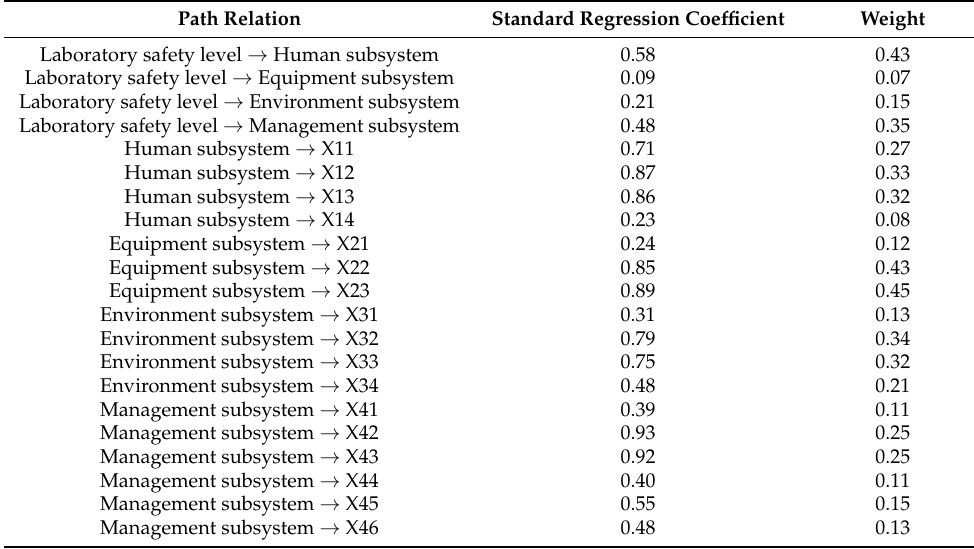
Table 8. Standardized regression coefficients and corresponding normalized